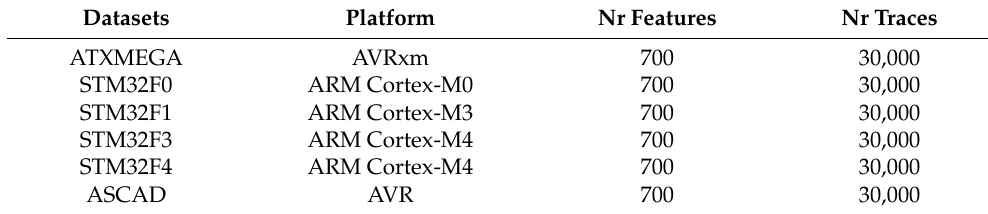
Table 1. Summary of all considered SCA datasets.